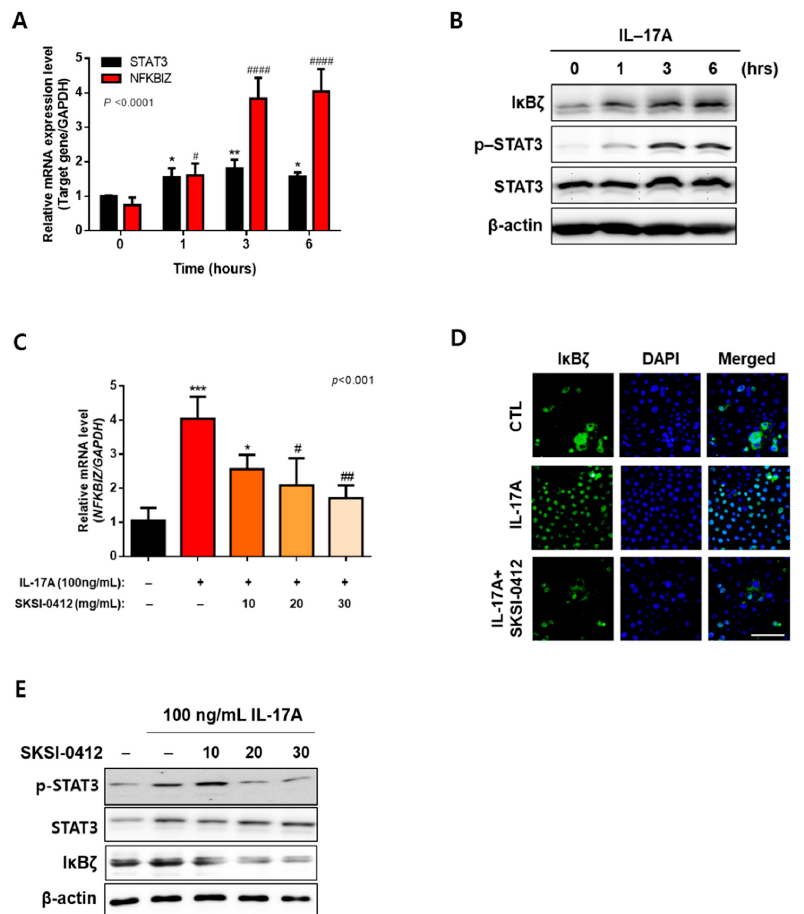
Figure 3. SKSI-0412 down-regulates the transcription of NFKBIZ by inhibiting STAT3 phosphory- lation. ( A ) Gene and ( B ) protein expression of STAT3 and NFKBIZ is increased for 6 h by IL-17A- induced keratinocytes. * p < 0.05, ** p < 0.01 compared with 0 h STAT3; # p < 0.05, #### p < 0.0001 compared with 0 h NFKBIZ, ANOVA one-way test. ( C ) SKSI-0412 decreased the expression of NFKBIZ mRNA via the transcription activity of STAT3 in IL-17A-induced KCs. * p < 0.05, *** p < 0.001 compared with nontreated control; # p < 0.05, ## p < 0.01 compared with IL-17A treatment sample, ANOVA one-way test. ( D ) Down-regulation of NFKBIZ caused a decrease in I κ B ζ accumulation in the nucleus. ( E ) The changes of I κ B ζ expression and STAT3 phosphorylation were confirmed by Western blot after SKSI-0412 treatment for 6